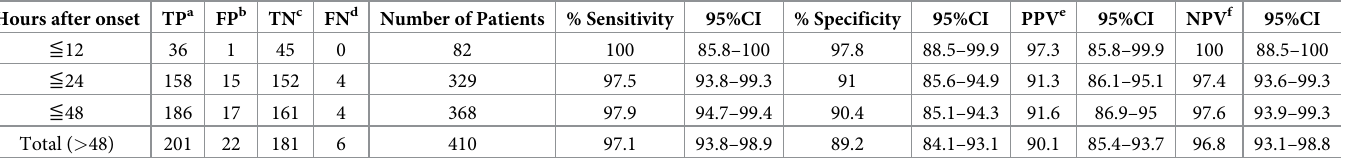
Table 2. Accumulated sensitivity and specificity of ImunoAce Flu.